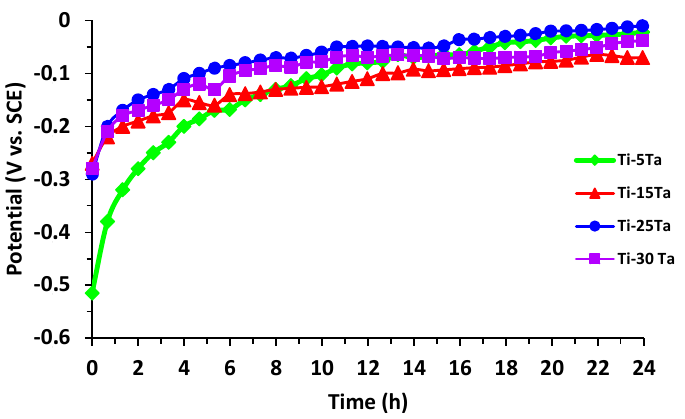
Figure 4. Open circuit potential curves for Ti–xTa alloys during 24 h immersion in SBF.